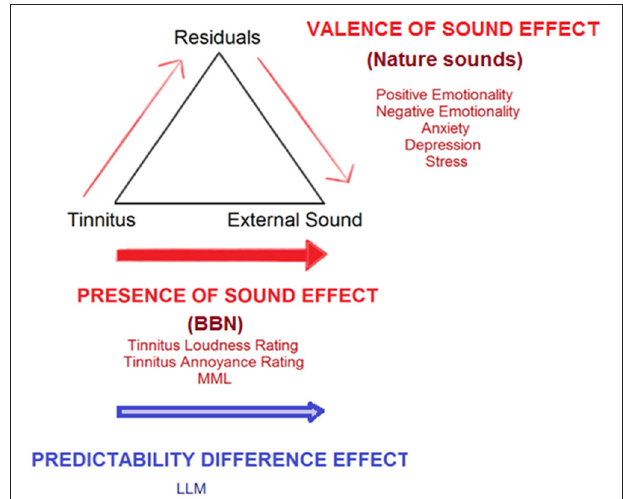
FIGURE 12 | Conceptualization of current study findings under an adaptation level theory (ALT) framework for tinnitus perception ( Schecklmann et al., 2013b). Tinnitus is envisaged as a sensory stimulus with an existing internal adaptation level (AL) which acts as a reference point for all tinnitus-related judgments and is able to be manipulated by context and time. A high tinnitus AL results in tinnitus that is judged by the sufferer as being of high magnitude and/or eliciting high distress. Three key components set the final AL: (1) the focal component/stimuli being attended to (tinnitus), (2) background stimuli, as well as (3) residuals (various psychological and cognitive individual influences, including emotion, personality, past experiences, arousal, and level of prediction elicited by sound stimuli). The “presence of sound effect” (red arrows) illustrates steady shifts in AL away from the tinnitus and toward sound therapy stimuli, which can occur by directly increasing the weighting placed on external sound, via attention, and auditory streaming shifts. A valence of sound effect increases weighting placed on external sound via the residual pathway. The latter occurs as external sounds provide psychological relief from tinnitus and can counteract tinnitus-related negative emotions, anxiety, stress, and depression, thereby creating a facilitating residual effect which reduces tinnitus severity. The “predictability difference effect” (blue arrow) illustrates a potential difference between BBN and nature sounds in terms of the amount of prediction errors elicited; this may also influence the degree of adaptation each sound undergoes over time. Shifts in AL away from tinnitus toward external sound would discontinue upon adaptation of the auditory system to the external sound itself. Auditory system adaptation to BBN and natural sound therapy may occur at different rates. Adaptation to BBN occurs sometime between 4 and 8 weeks after the first introduction of the sound, leading to the need to increase the sound level required to match tinnitus in Loudness Level Matching. There may be small but immediate valence effects, but nature sounds due to their intermittent nature may take longer to reach peak adaptation, such that at 8 weeks no change in Loudness Level Matching may be